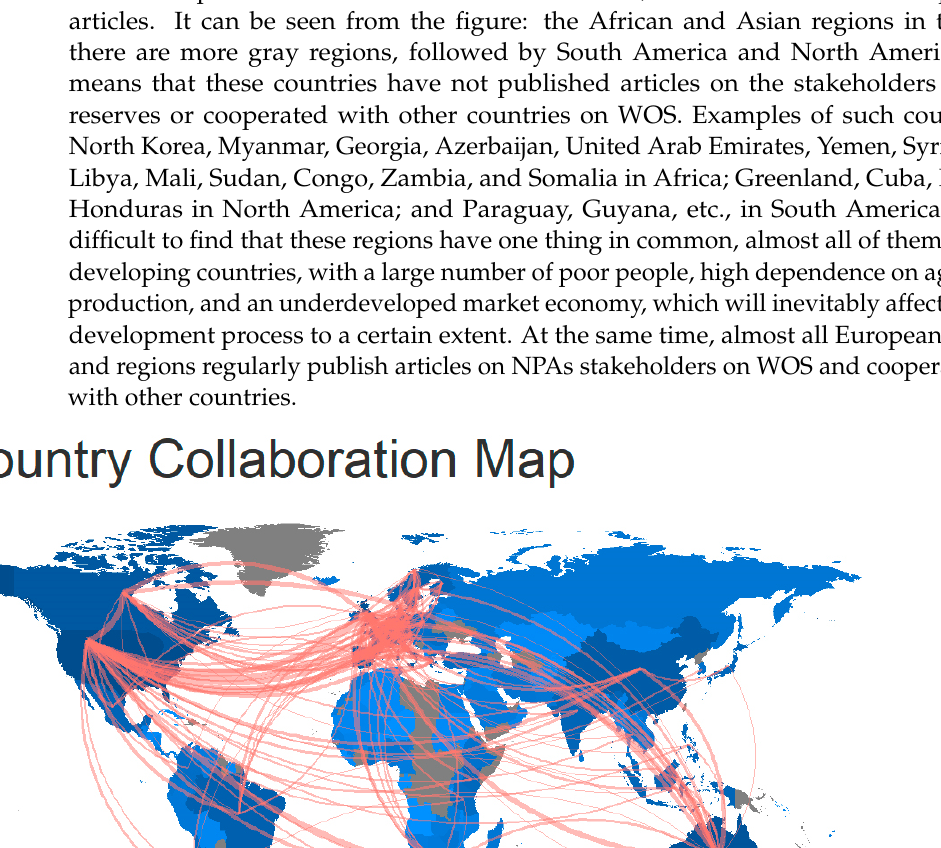
Figure 5. World map of country publications and collaboration on NPAs research topics. The color gradient represents the number of published articles, the darker the color, the more the number of published articles.